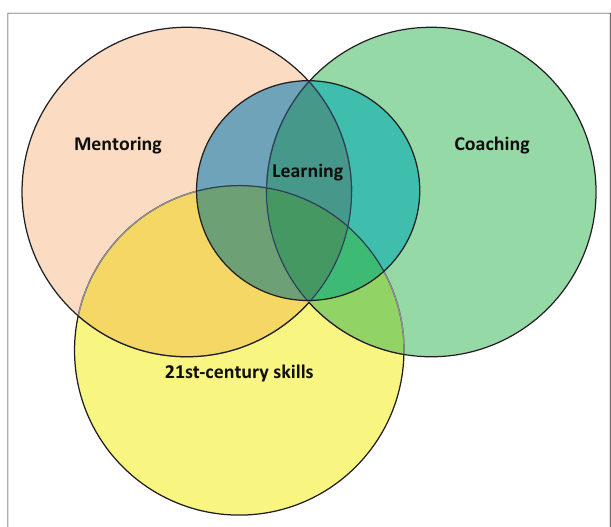
FIGURE 2: Overlap